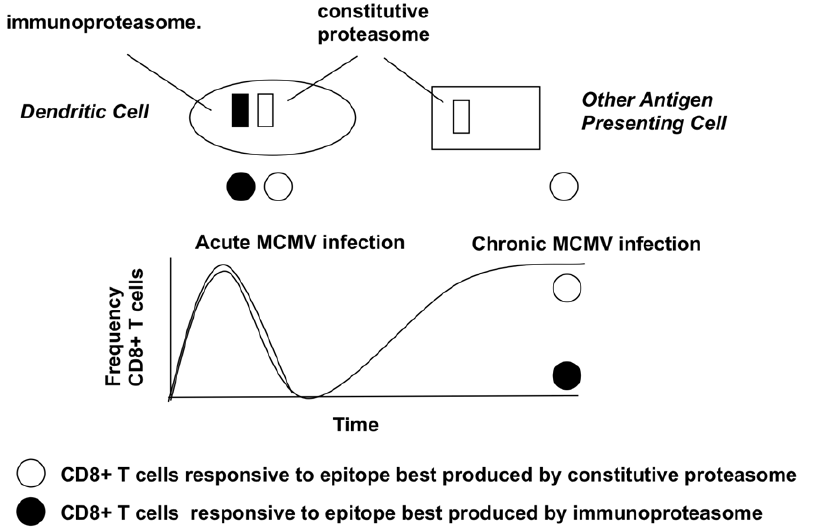
Figure 7. ‘‘2-cell’’ model to explain different effect of LMP7 on ‘‘inflating’’ memory and classical memory CD8 + T cell responses to MCMV. Infected or cross-presenting DCs during acute infection contain immunoproteasomes and constitutive proteasomes and stimulate responses to epitopes produced by either proteasome. In chronic infection other APCs containing only constitutive proteasomes stimulate responses only to those epitopes produced by the constitutive proteasome resulting in selection of more immunoproteasome-independent responses during chronic infection.